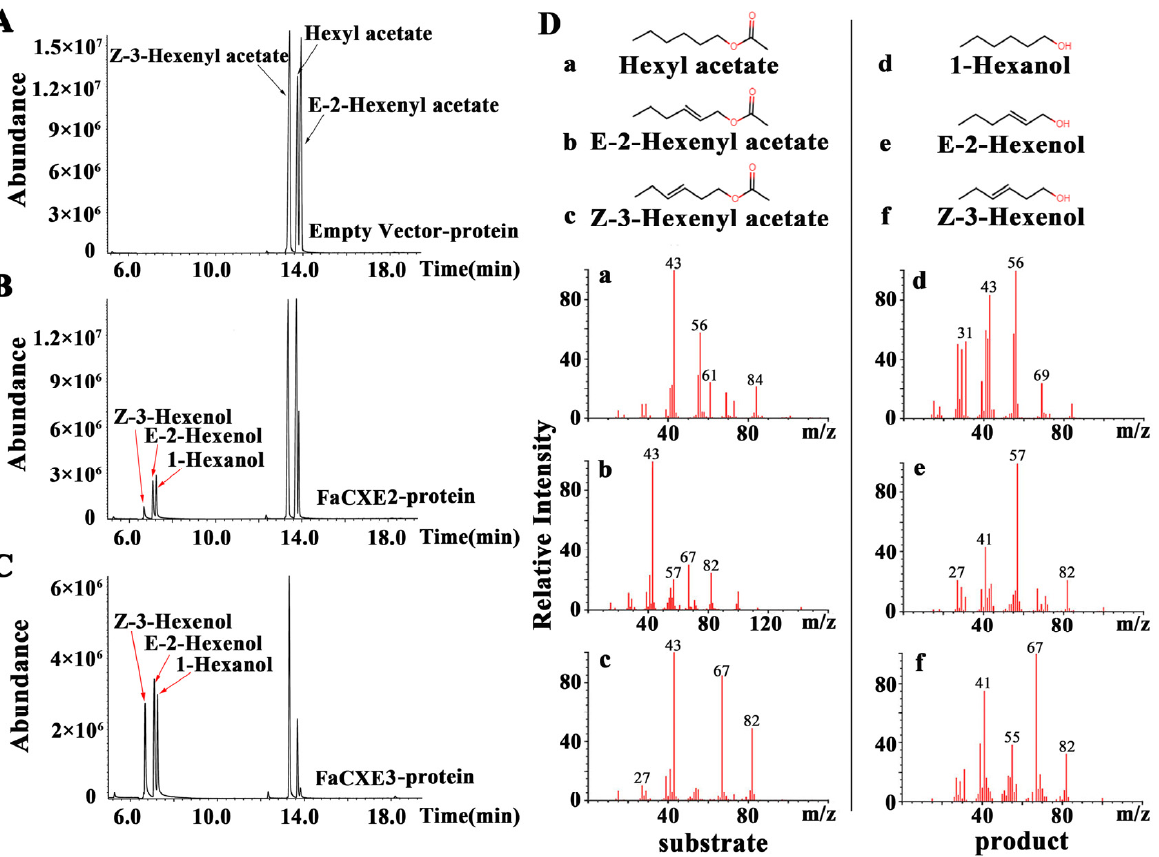
Figure 5. Enzyme activity analysis of rFaCXE2 and rFaCXE3. ( A – C ) The hydrolysis activities of FaCXEs using hexyl acetate, E -hexenyl acetate, and Z -3-hexenyl acetate as substrates. ( D ) Chemistry structural formulas and MS/MS profiles of three substrates and three products.